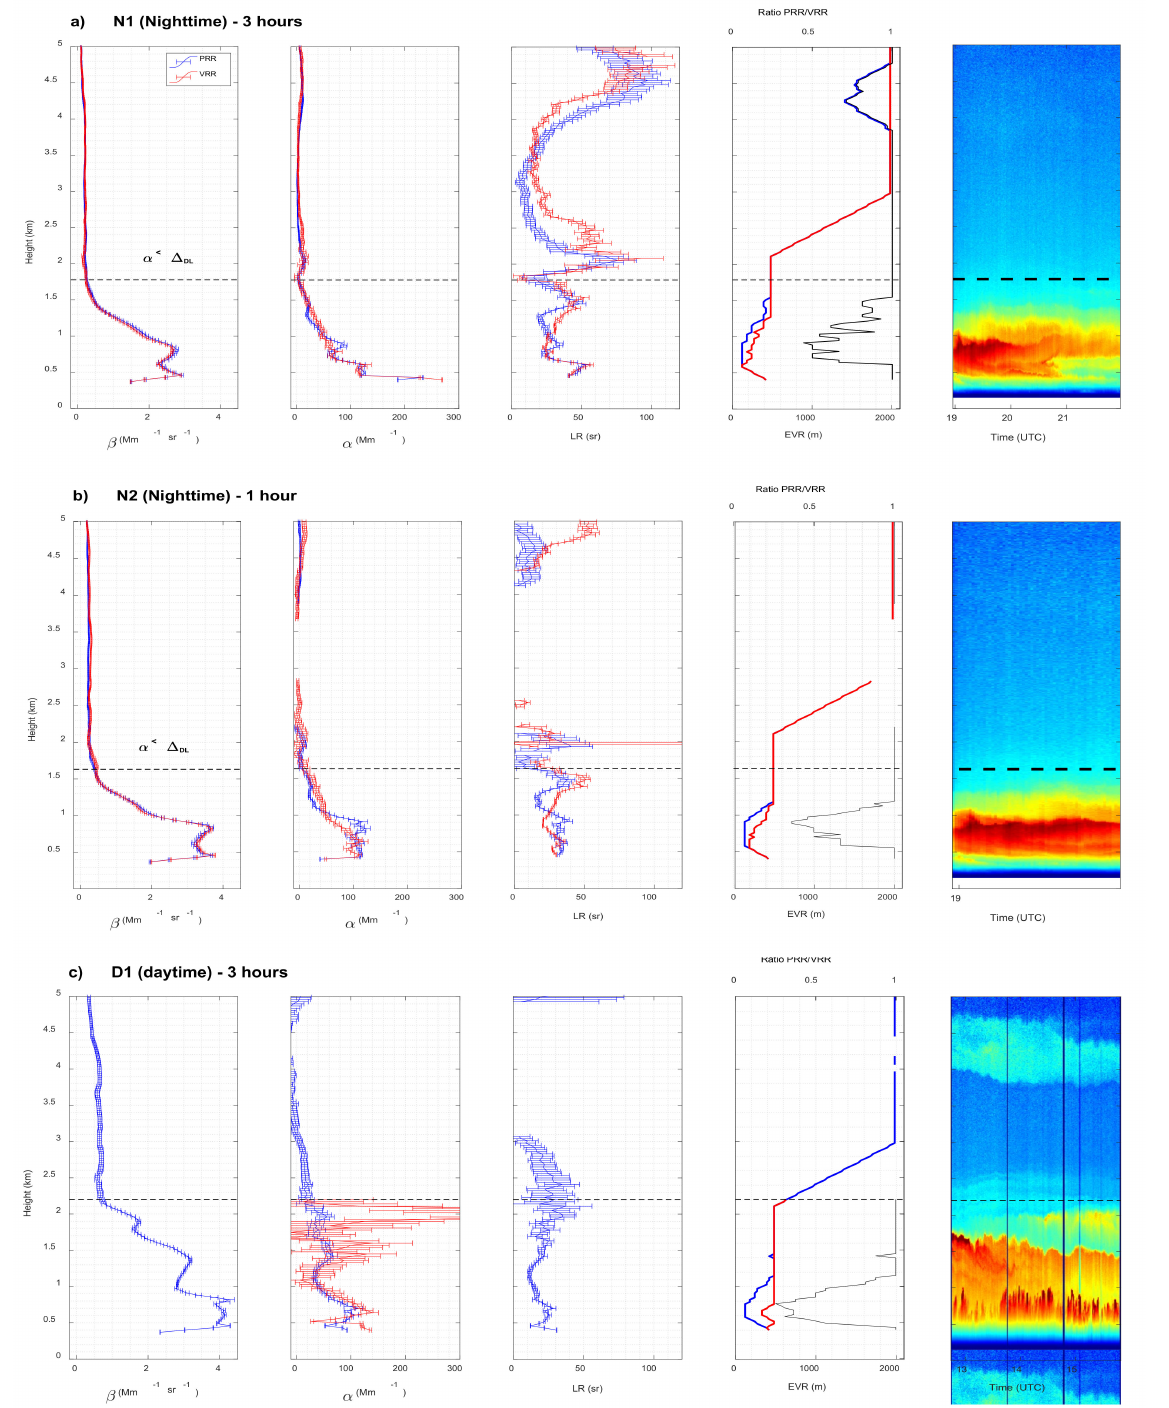
Figure 8. Aerosol backscatter and extinction coefficients, lidar ratio and effective vertical resolution retrieved by the Single Calculus Chain (SCC) from PRR and VRR signals for case ( a ) N1, ( b ) N2 and ( c ) D1. On the plot of the vertical resolution, the ratio of the resolutions PPR to VRR is reported (black line, top axis). Time-height plots of the range-square corrected signal (in arbitrary units) are reported in the far-right plot. In ( a , b ) the black horizontal dashed line represents the lowest height for which α < ∆ DL . In ( c ) it represents the highest height for which α | VRR is retrieved. The legend in the first plot of Figure 8a applies to all